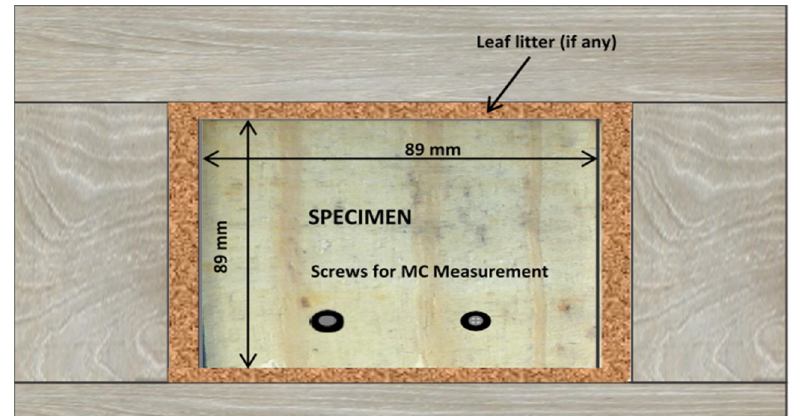
Figure 1. Physical configuration of specimen holder used in this study. The wood block was surrounded by either aged or leaf litter and allowed to weather. Black holes near the bottom were used to obtain moisture content at each observation. The assembly shown represents one replicate.